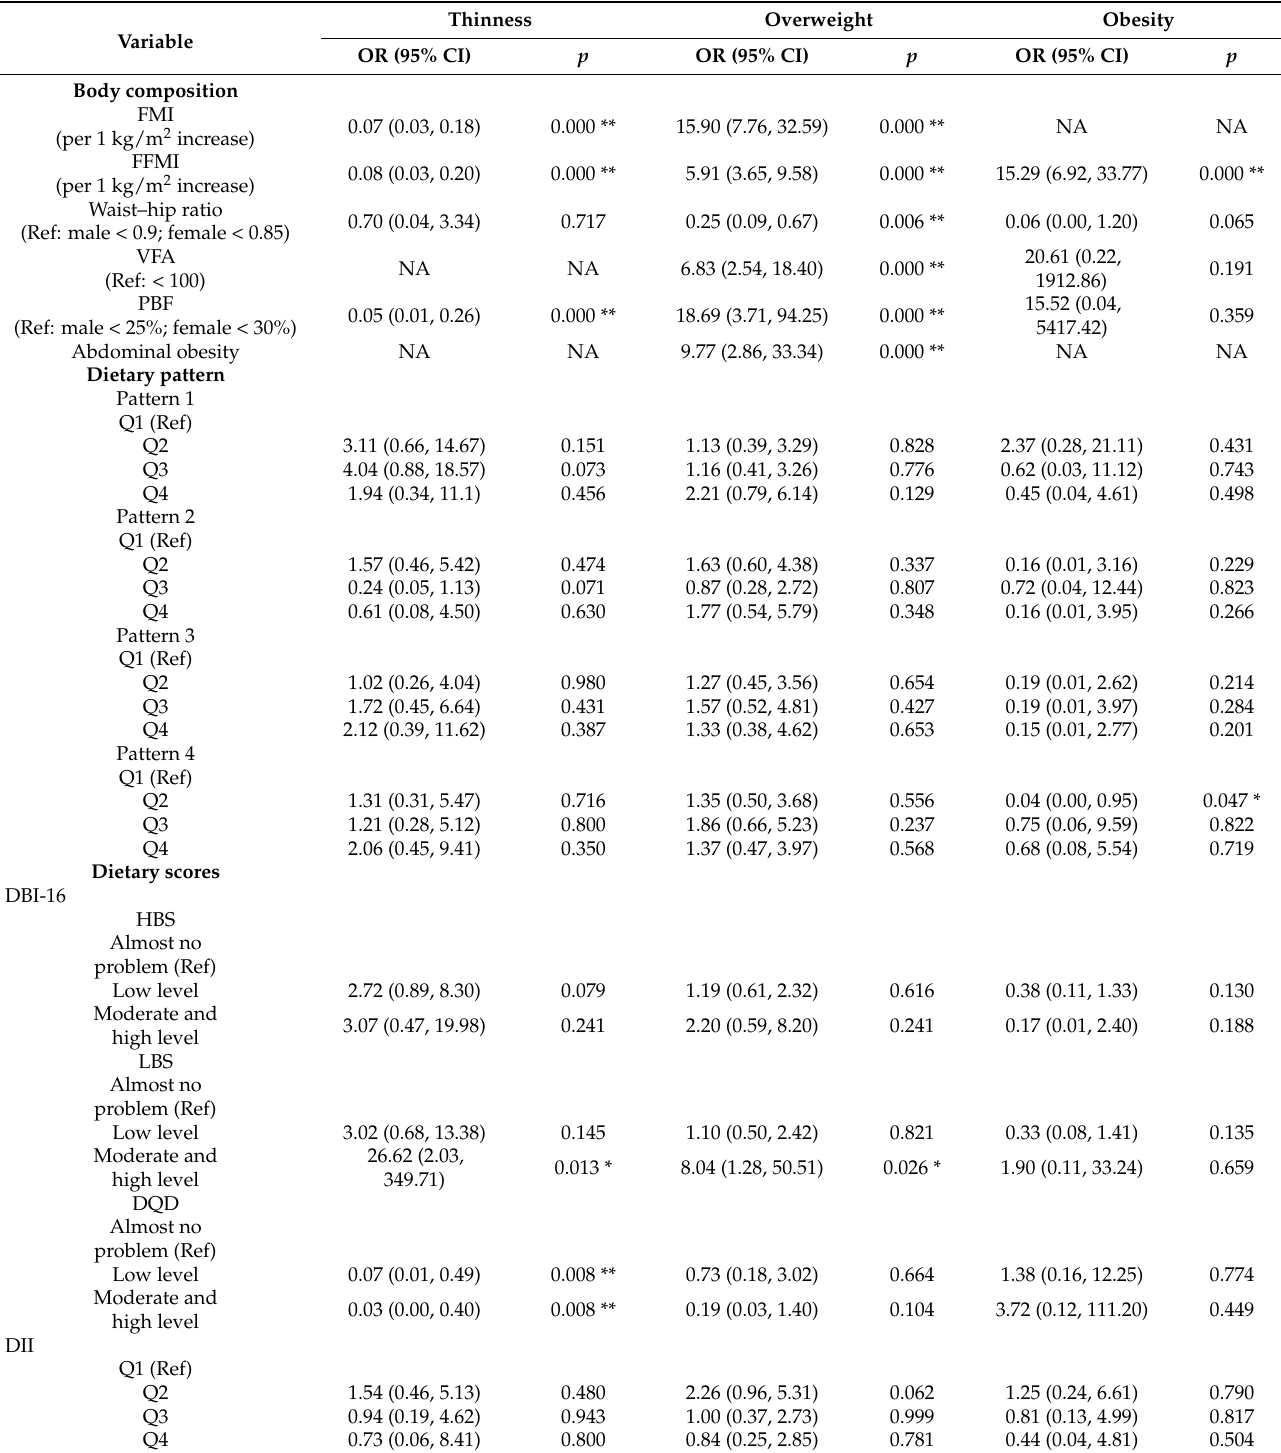
Table 5. Factors contributing to different